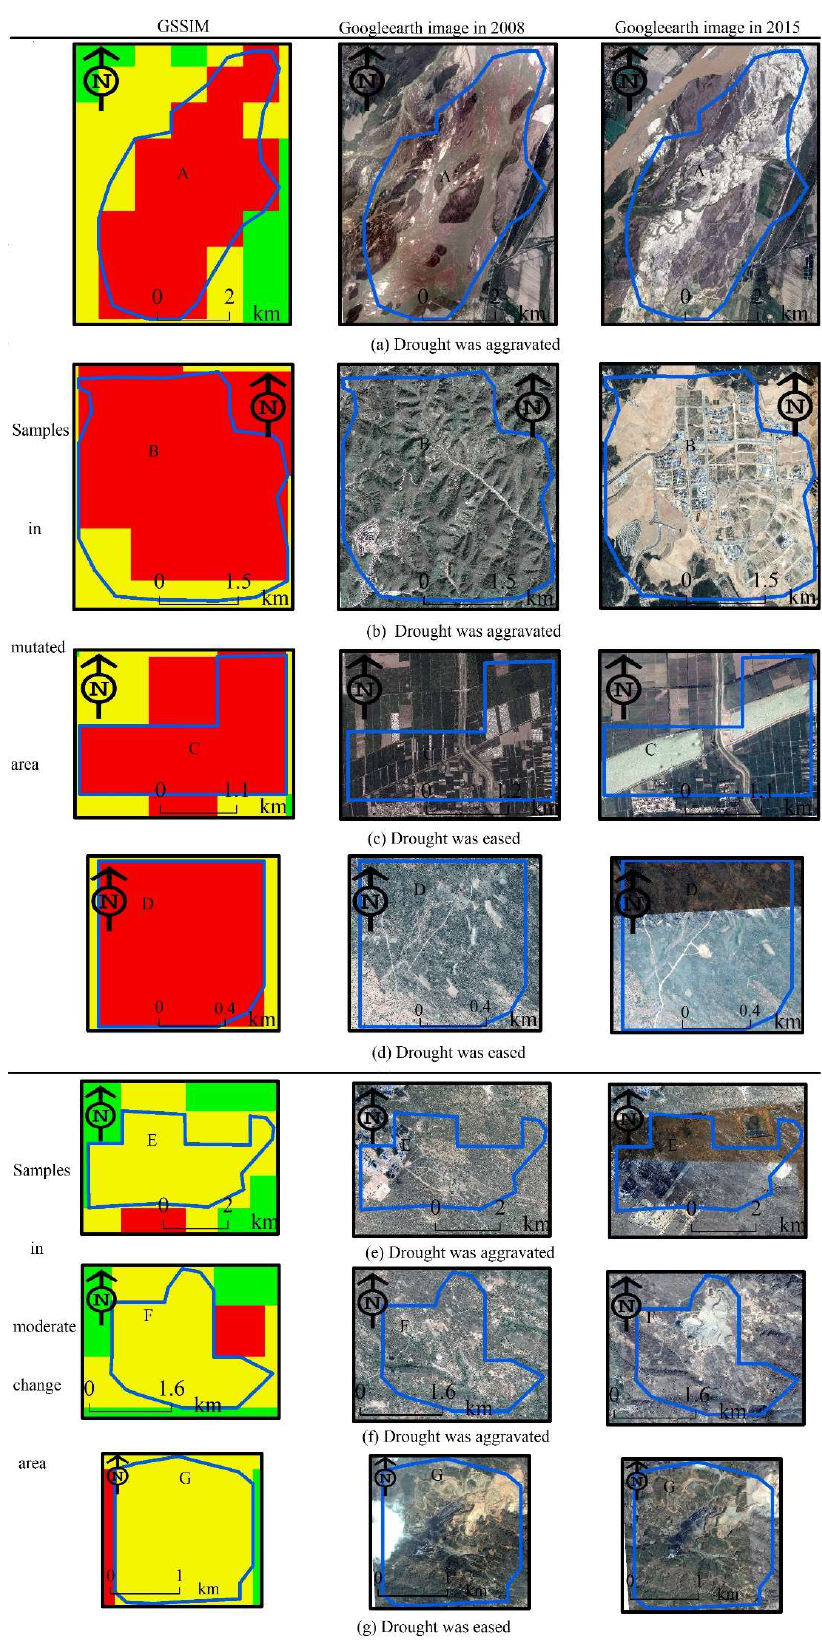
Figure 8. Samples of mutation (A, B, C, D) and moderate variation (E, F, G). ( a , b , e , f ) drought was eased, ( c , d , g ) drought was aggravated.